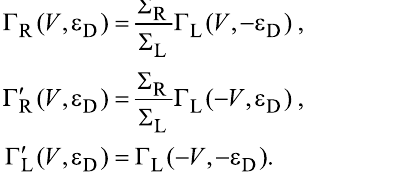
Figure 2: I – V -characteristics for symmetric coupling ∑ L = ∑ R and for varying electron–phonon coupling m 0 at inverse temperature θ = 25 (solid) and θ = 10